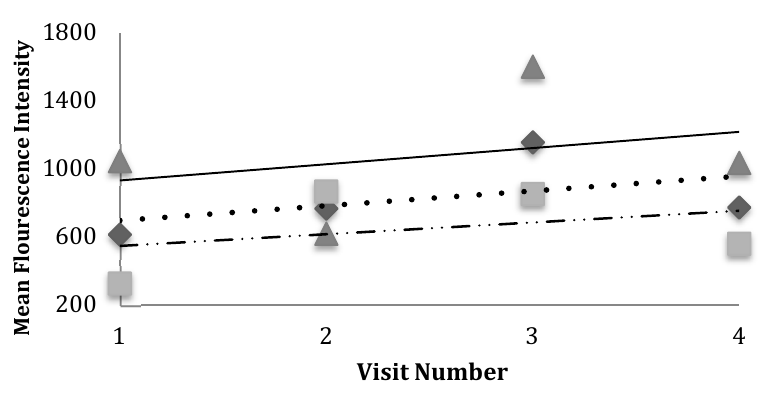
Figure 3. Scheme illustrating change in mean superoxide levels over visits. Peripheral blood samples assessed using flow cytometry. Superoxide, measured by HE, was different between older and younger groups. Log transformed measures were fitted into a mixed model which demonstrated superoxide level was different between older and younger groups ( p = 0.0413), changed over time ( p = 0.0434), and changed in the same direction over time (increase: p = 0.2854). Table 3. Kilocalorie and macronutrient intake by age